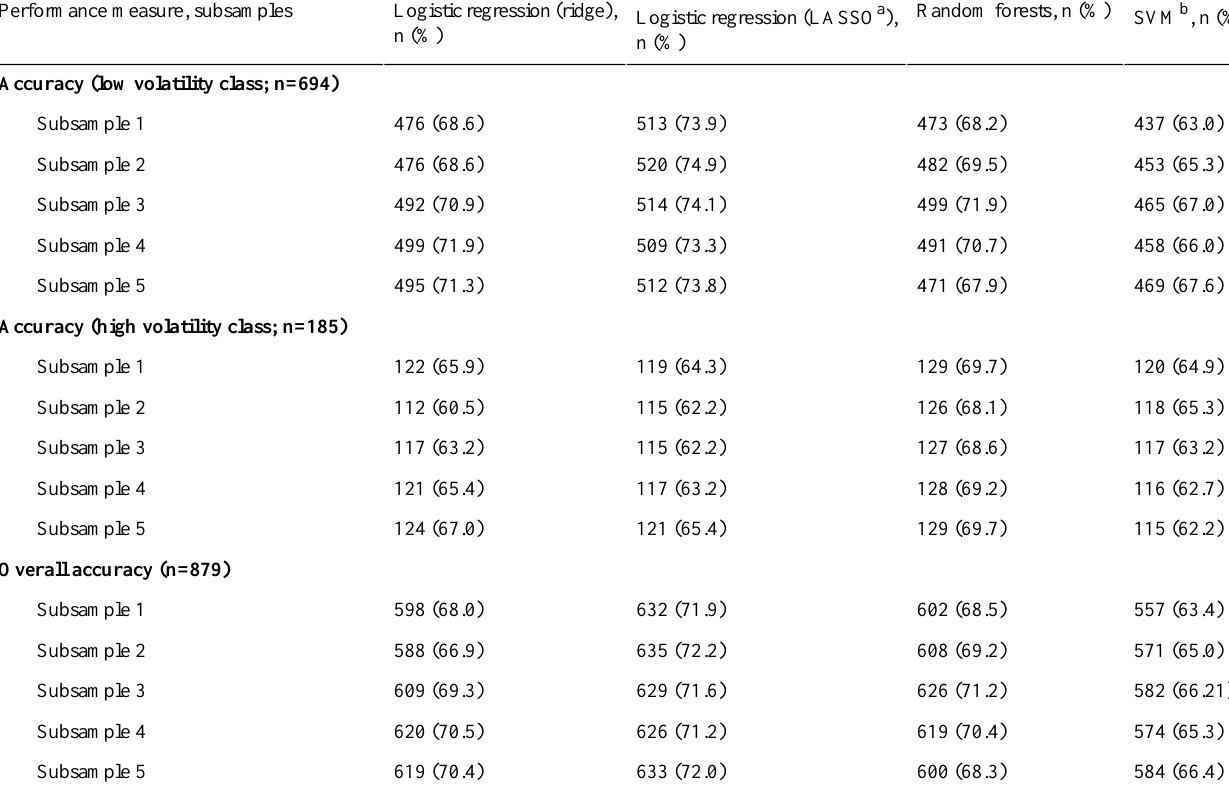
Table 1. Prediction performance using all 132 features. Random under-sampling of the majority class (low volatility) was applied and repeated 5 times to make class sizes equal in the training